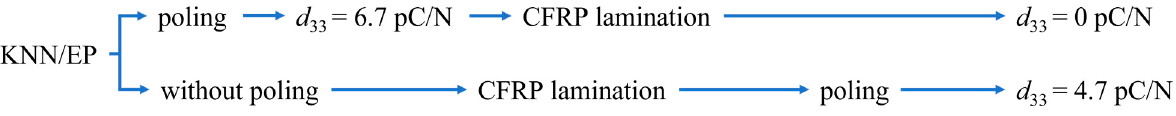
Figure 7. Comparison of the piezoelectric coefficients, d 33 .